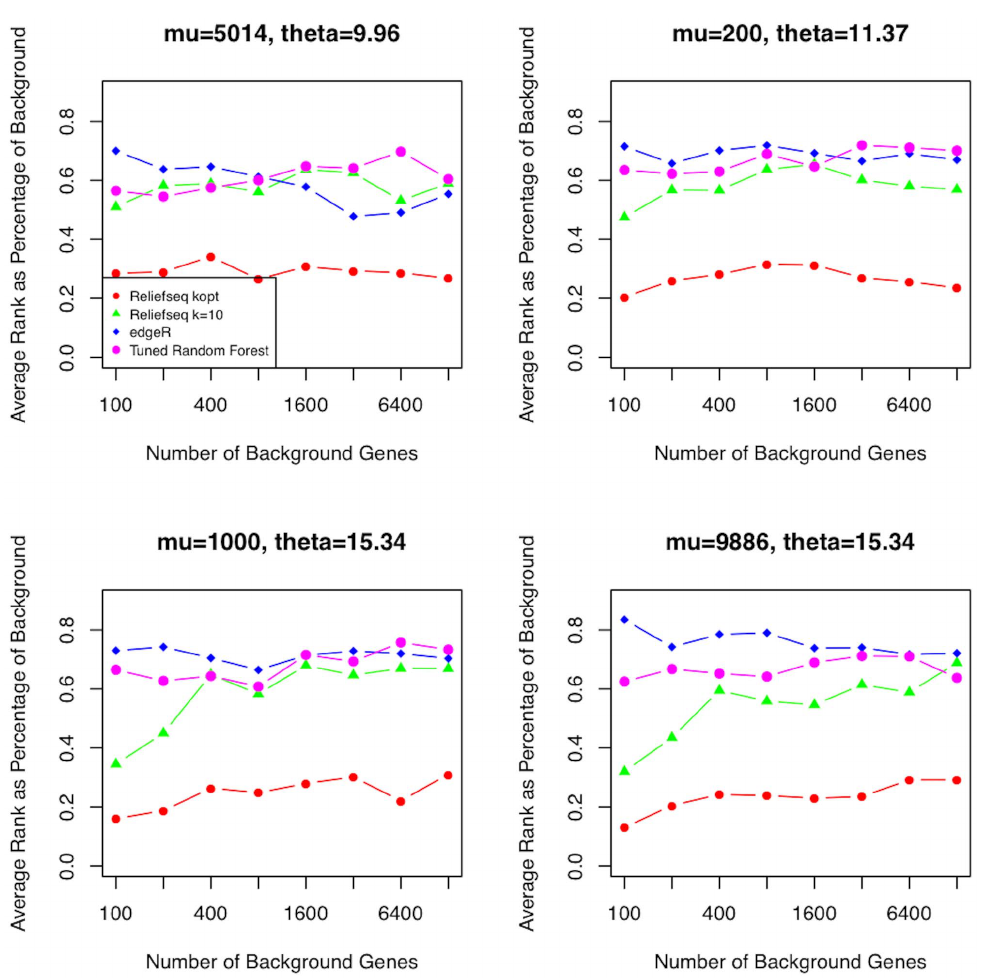
Figure 8. Interaction simulation comparison of feature ranking methods for different numbers of null genes. Comparison of optimized-k Relief-F, standard Relief-F using k=10 nearest neighbors, edgeR, and tuned Random Forest for detecting an interaction between two genes amongst various numbers of null genes. The panels are sorted in order of increasing negative binomial parameter h . Each point is the average of the worst ranking gene of the two simulated interacting genes across n=100 replicate simulations and then divided by the total number of simulated genes. The number of null or background genes increases from 100 to 12,800 total genes, plotted on the log2 scale. Each simulation contains one pure interaction (no main effects) XOR model between two negative binomial genes.